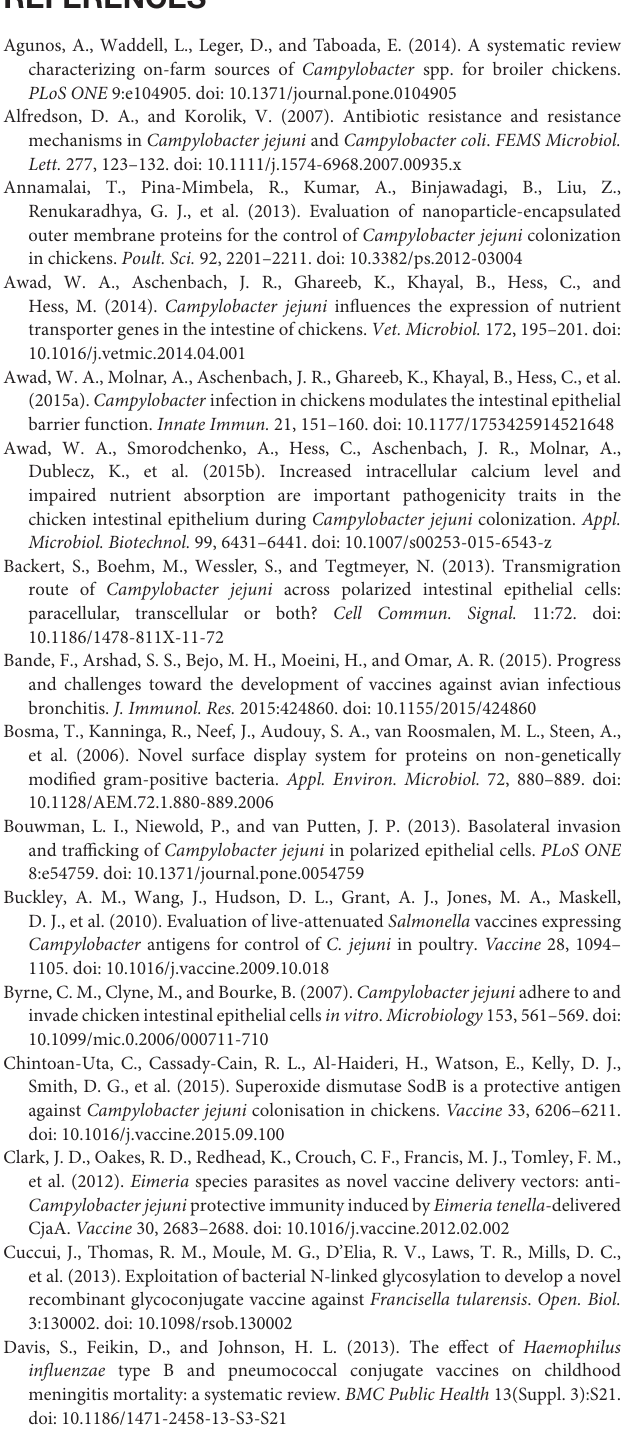
FIGURE S3 | Localization of rCjaADLysM fusion protein on TCA- pretreated L. salivarius . Fusion protein were visualized with anti-rCjaAD antibodies that were further detected with goat anti-rabbit IgG Alexa Fluor A488. Fluorescence was visualized with a NIKON A1R MP microscope. The bar represents 2 µ